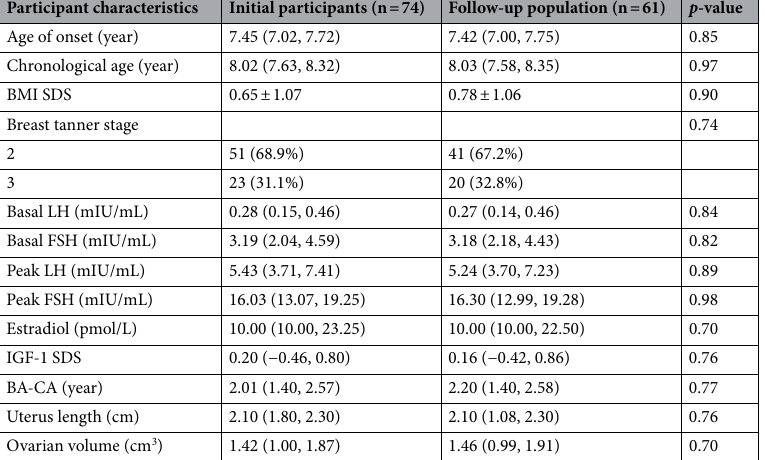
Table 1. Participant characteristics. BMI Body mass index, SDS Standard deviation score, LH Luteinizing hormone, FSH Follicle-stimulating hormone, IGF-1 Insulin-like growth factor-1, BA-CA Bone age minus chronological